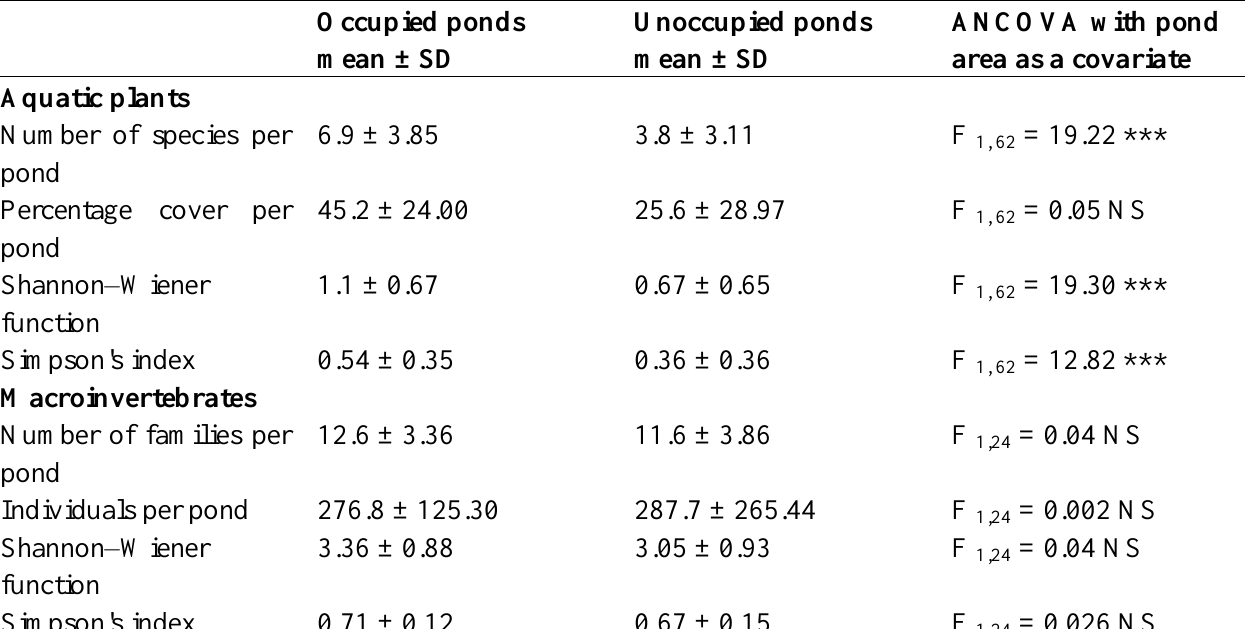
Table 2. Diversity of aquatic plants and macroinvertebrates in ponds with and without great crested